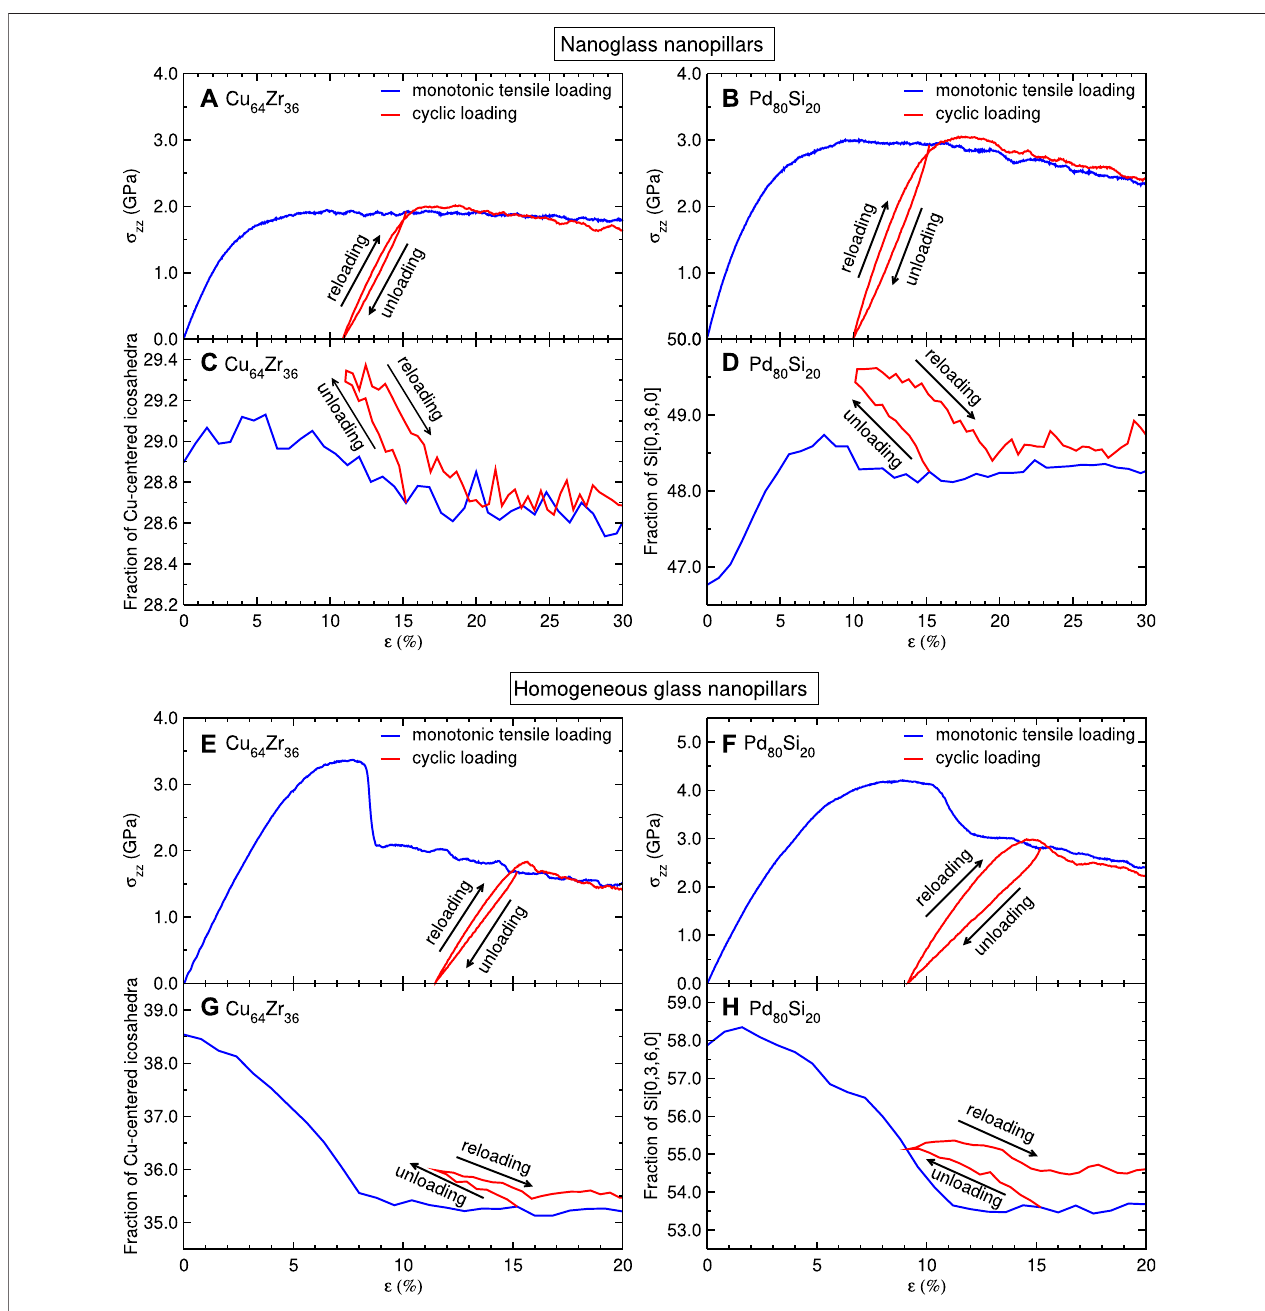
FIGURE 2 | Cu 64 Zr 36 and Pd 80 Si 20 nanoglass (NG) and homogeneous glass (HG) nanopillars with a diameter of 18 nm under cyclic loading. (A,B) Engineering stress – strain curves for NG nanopillars. (C) Variation of Cu-centered icosahedra in the Cu 64 Zr 36 NG nanopillars, including full icosahedra (index [0,12,0,0]) and disordered icosahedra (indexes [0,2,8,2] and [0,3,6,3]) as a function of the engineering strain. (D) Variation of the most prominent Voronoipolyhedra in the Pd 80 Si 20 NG nanopillar, Si[0,3,6,0], as a function of the engineering strain. (E,F) Engineering stress – strain curves for HG nanopillars. (G) Variation of Cu-centered icosahedra in the Cu 64 Zr 36 HG nanopillars as a function of the engineering strain. (H) Variation of the most prominent Voronoipolyhedra in the Pd 80 Si 20 HG nanopillar, Si[0,3,6,0], as a function of the engineering strain. The engineering stress – strain curves for the monotonic loading of 18 nm Cu 64 Zr 36 and Pd 80 Si 20 NG and HG nanopillars are reproduced for